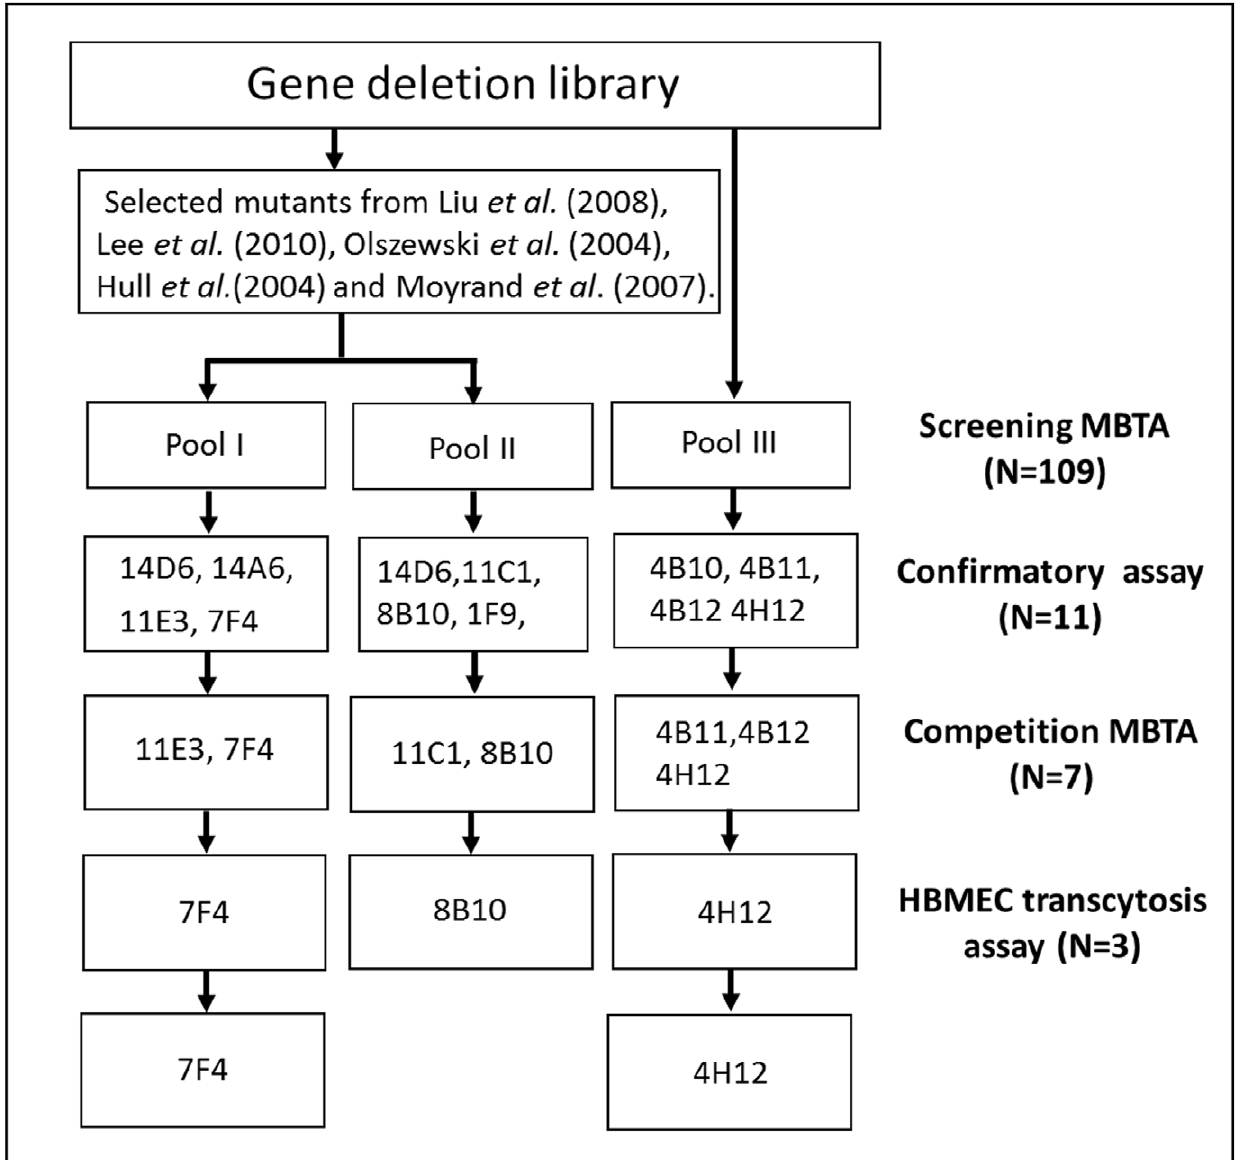
Figure 2. The flow chart of 109 cryptococcal mutants in three pools tested in this study. The 7F4 clone and 4H12 clone are identified as BBB transmigration related mutants.